Question: How would you classify this visualization?
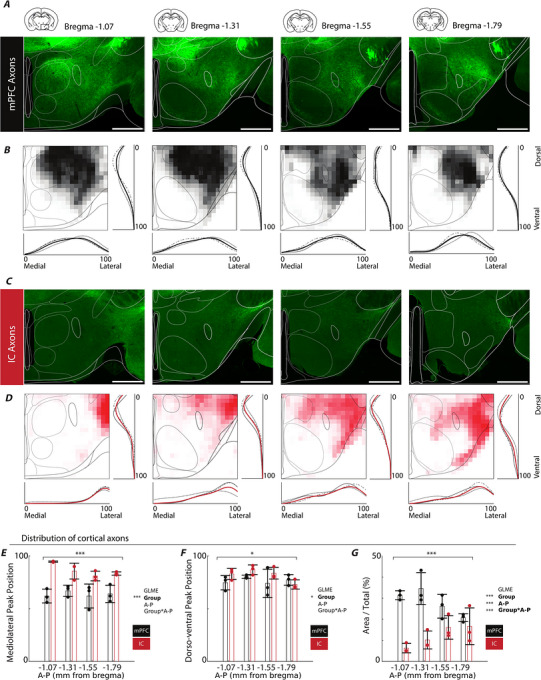
Answer: heatmap